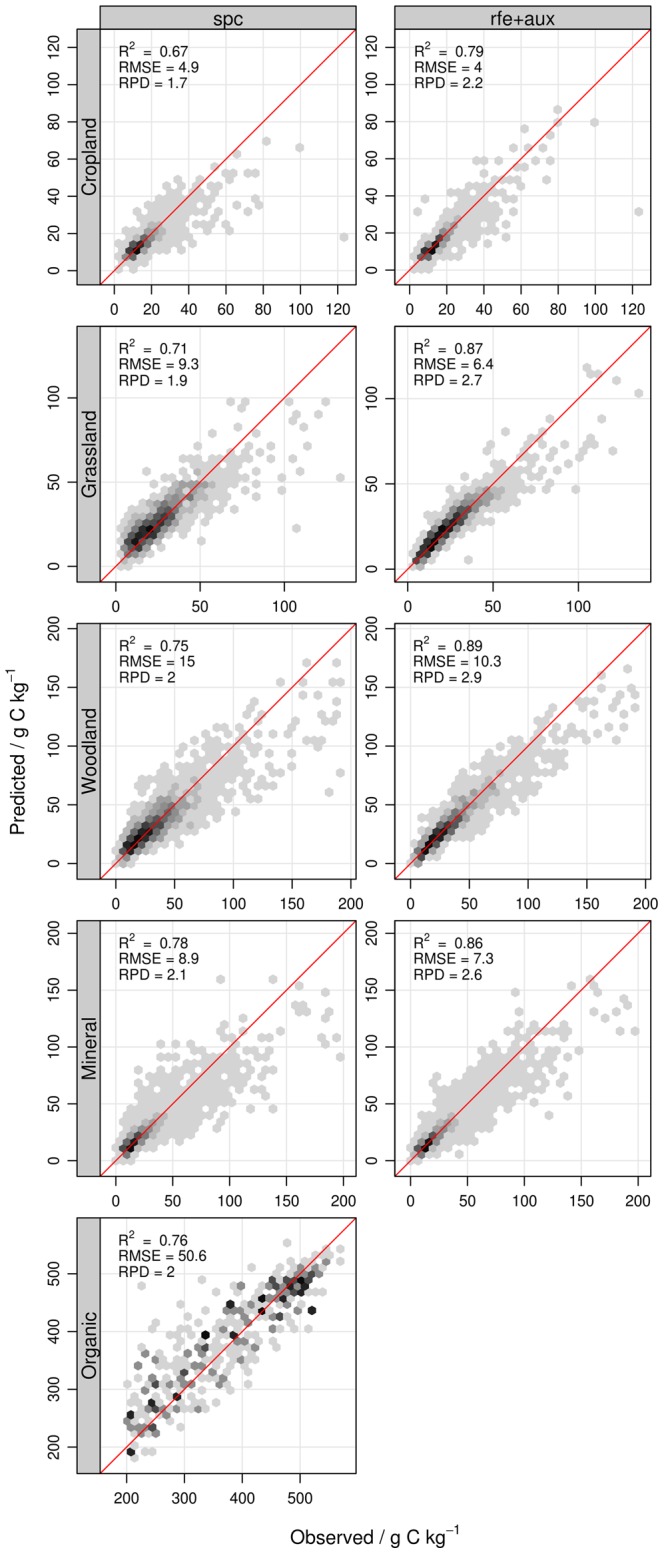
Predicted SOC content as a function of observed SOC content in test sets.Model predictions are shown for models with (rfe+aux, right panels) and without auxiliary predictors (spc, left panels).